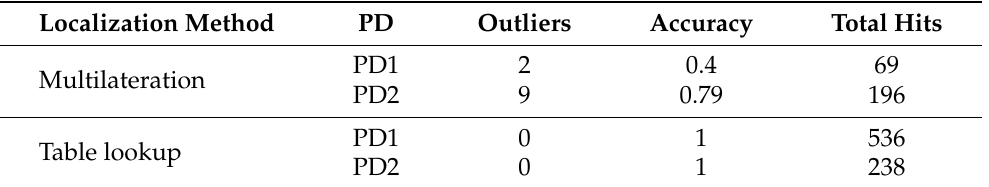
Figure 12. Localization results from FDTD table lookup on PD1 in KE20. The three axes are three dimensions of space (measured in mm). Many PD signals are determined to be from the same location, and there is no obvious outliers. All computed PD locations are well within the bounding box defined by the 500 mm tolerance. Table 1. Results with different localization methods and 500 mm